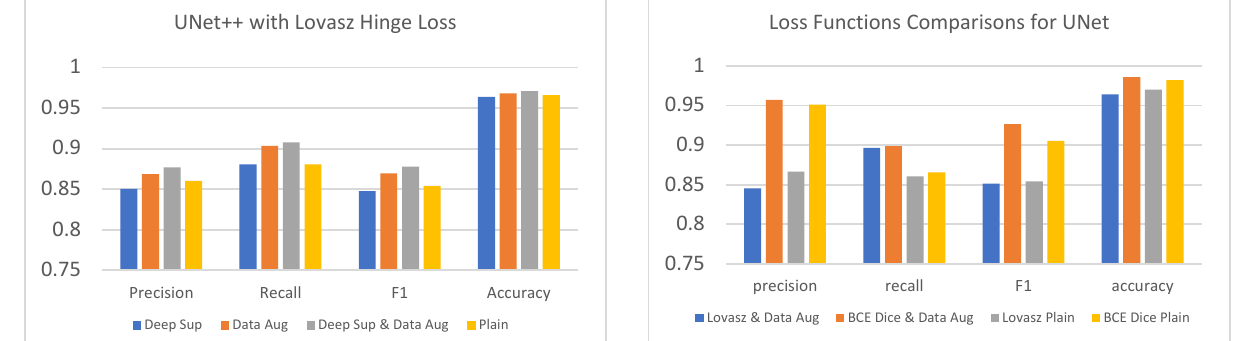
Figure 6: Comparison of the effects of using different loss functions on the UNet test results